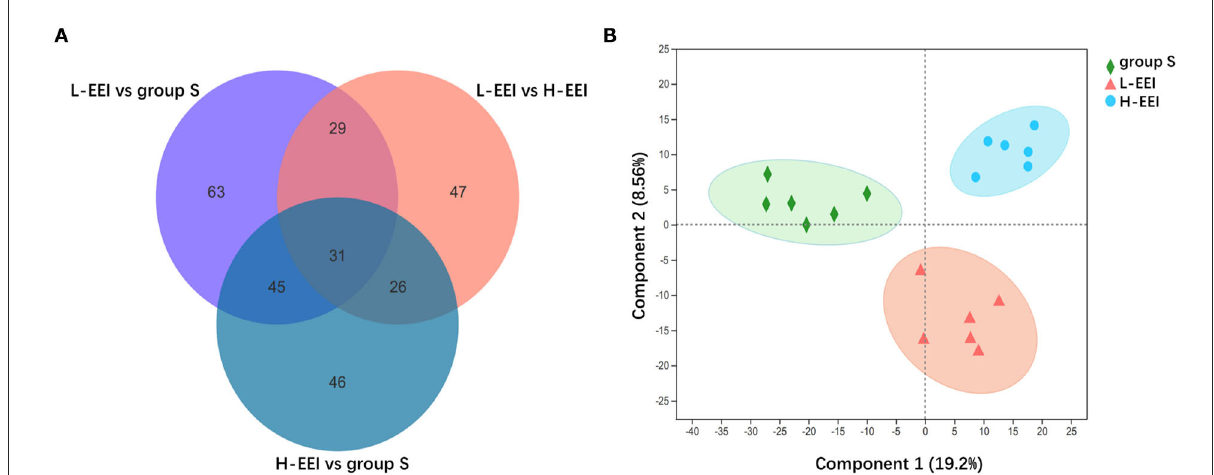
FIGURE4 L-EEI and H-EEI induced differential fecal metabolites. (A) The common or unique metabolites are found after a pairwise comparison of three groups. In the figure, the overlapping part represents the number of metabolites shared by multiple metabolic sets, the non-overlapping part represents the number of metabolites unique to the metabolic set, and the number represents the number of corresponding metabolites. (B) PLS-DA score plot. The PLS-DA score map is used to visually represent the classification effect of the model. The greater the degree of separation among the three groups of samples in the figure, the more significant the classification effect. Component 1 is the first principal component explainability, and Component 2 is the second principal component explainability. The data used in the analysis were derived from LC-MS data of feces ( n = 6 in each group).